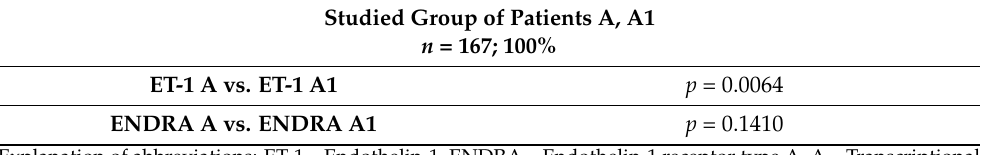
Table 5. Transcriptional activity of the endothelin-1 gene and endothelin-1 receptor type A among pa- tients after myocardial infarction heart before (A) and after early post-hospital cardiac rehabilitation (A1). Studied Group of Patients A,